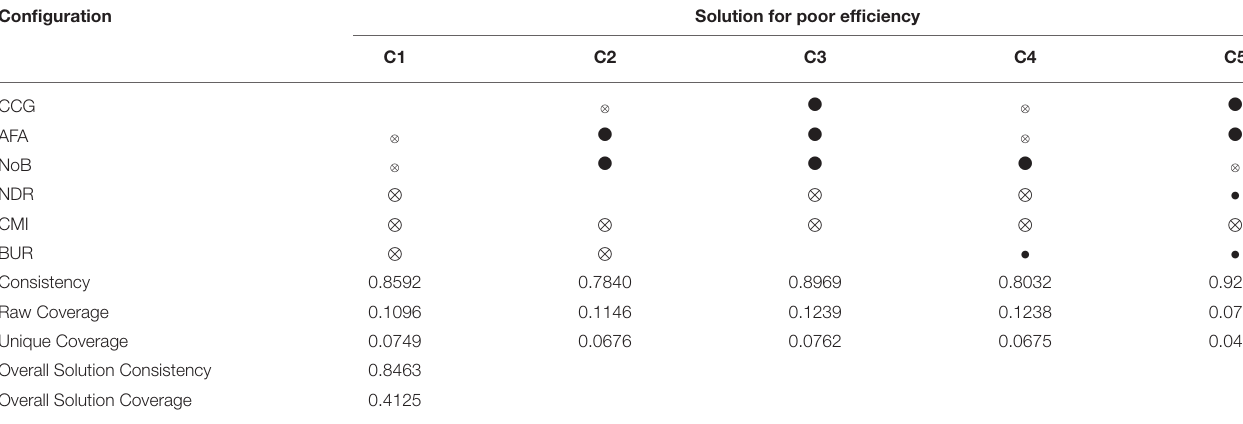
TABLE 6 | Configuration of conditions for poor efficiency.